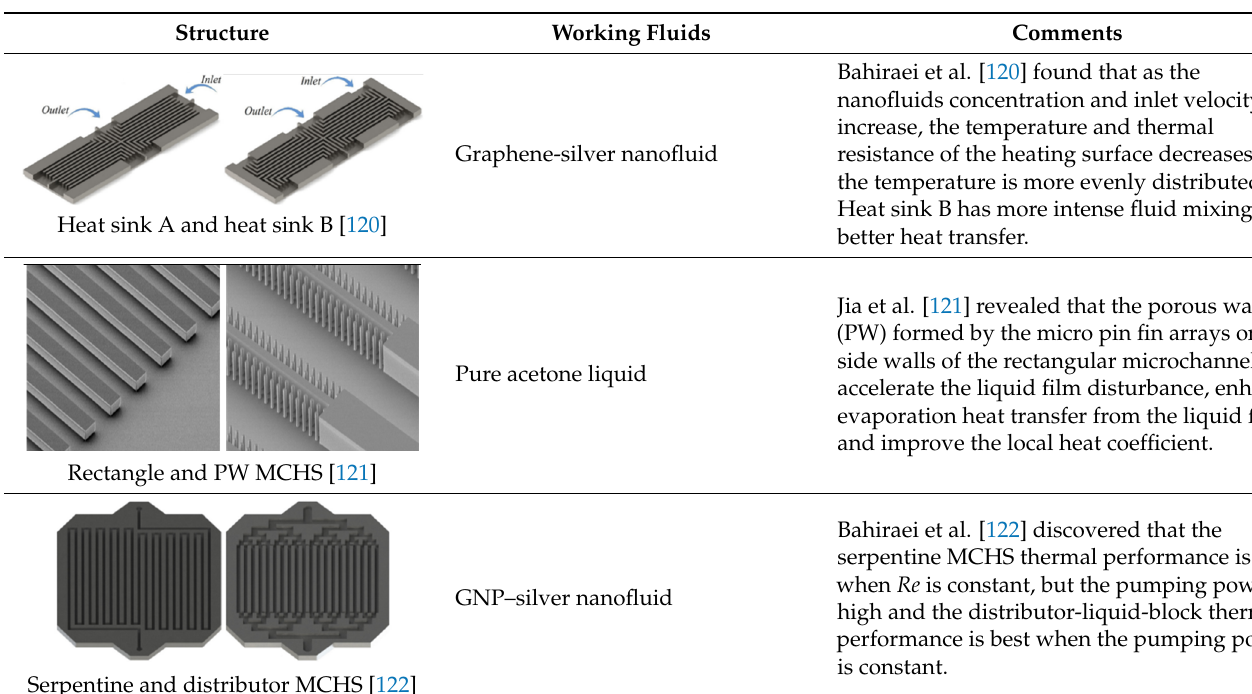
Table 6. The influence of microchannel distribution on the thermal-hydraulic performance of the MCHS.